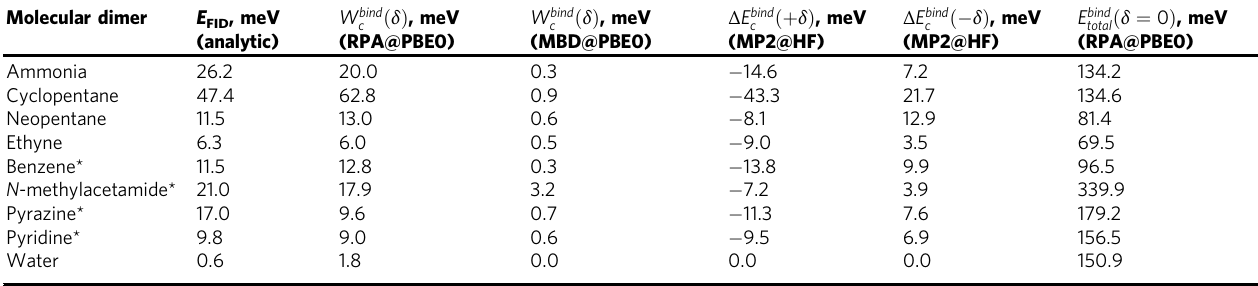
Table 1 Field-induced dispersion (FID) energy, de fi ned by Eq. (2), and its comparison with ab initio RPA and MP2 methods Molecular